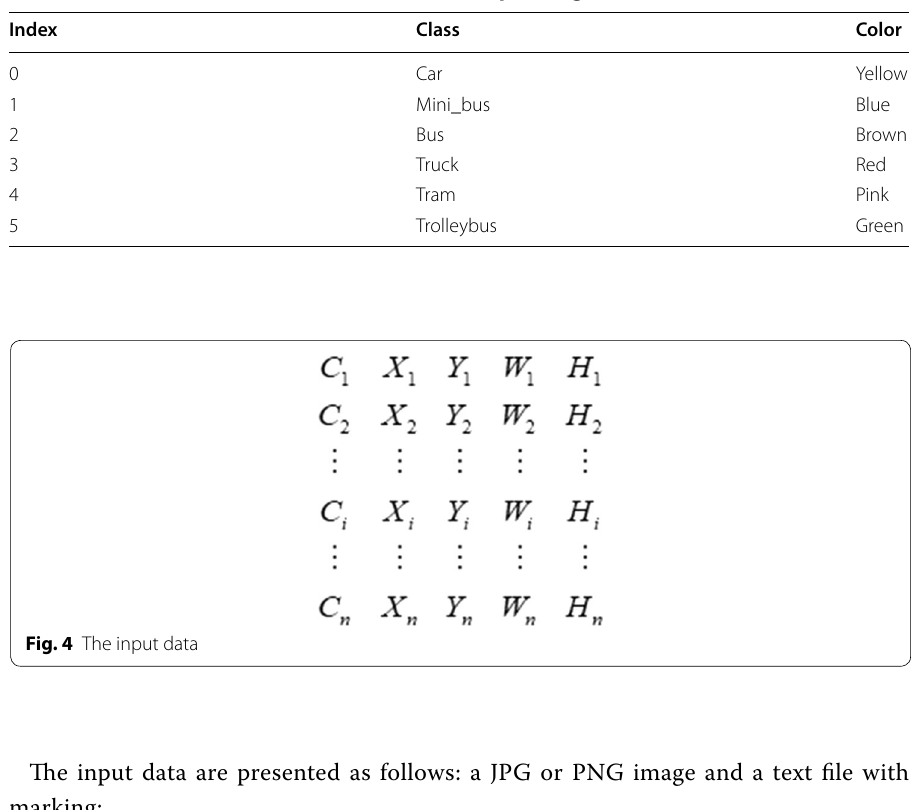
Table 1 Indexation of the classes and their corresponding colors